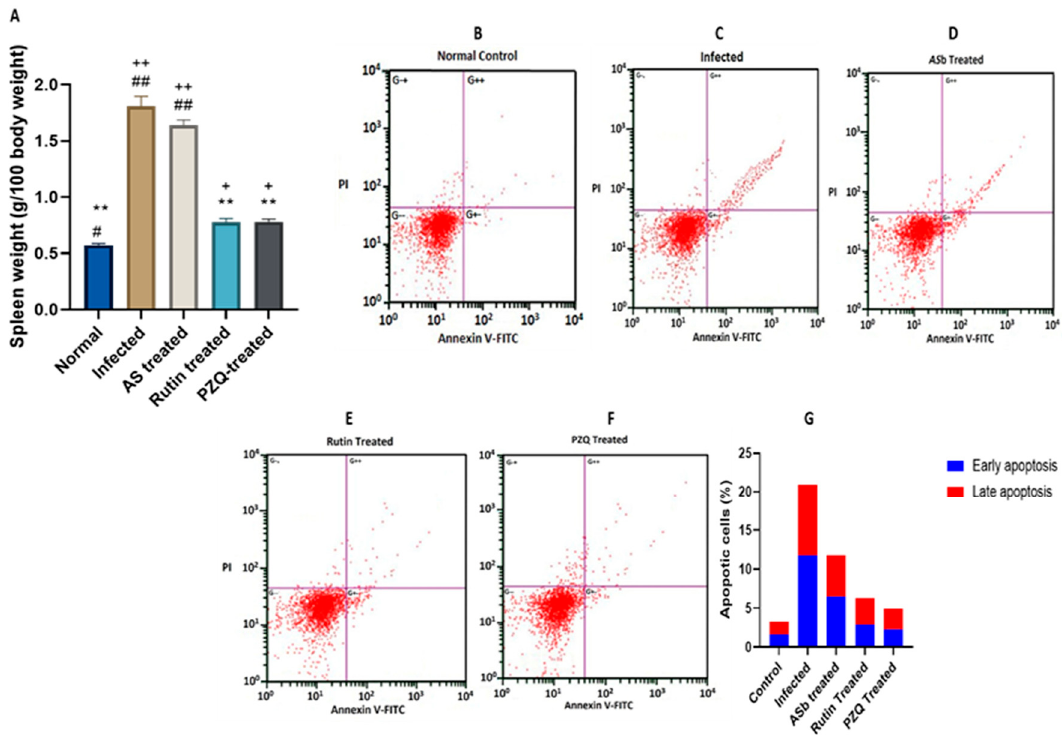
Figure 5. Effect of treatment with rutin naturally isolated from A. sativum on apoptosis in the spleen caused by infection with 100 ± 2 S. mansoni cercariae, 8 weeks postinfection. ( A ) Spleen weight (relative to body weight); ( B – F ) typical flow cytometry plots showing annexin V-FITC and PI double staining. The figure shows live cells in the bottom left quadrant (double negative); early apoptotic cells are displayed in the bottom right quadrant (Annexin V positive and PI negative), while late apoptotic cells are displayed in the top right quadrant (double-positive). ( G ) Percentages of viable cells, shown as the mean ± SE ( n = 5). ** p -value < 0.001, + p < 0.05, ++ p -value < 0.001, # p < 0.05, ## p -value <